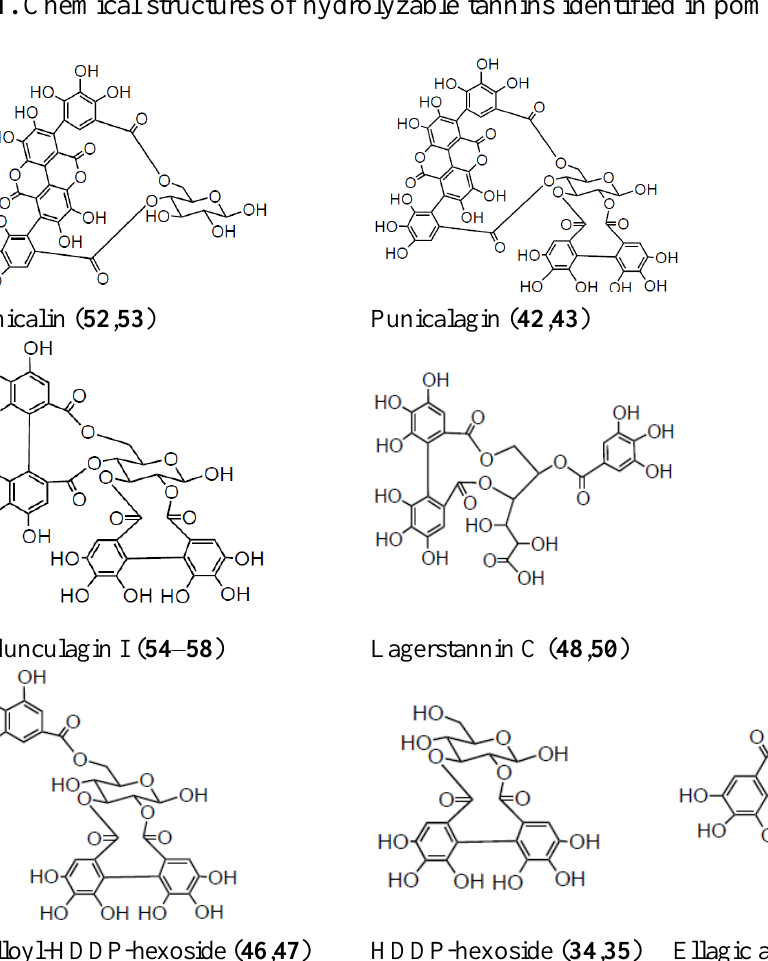
Figure 1. Chemical structures of hydrolyzable tannins identified in pomegranate